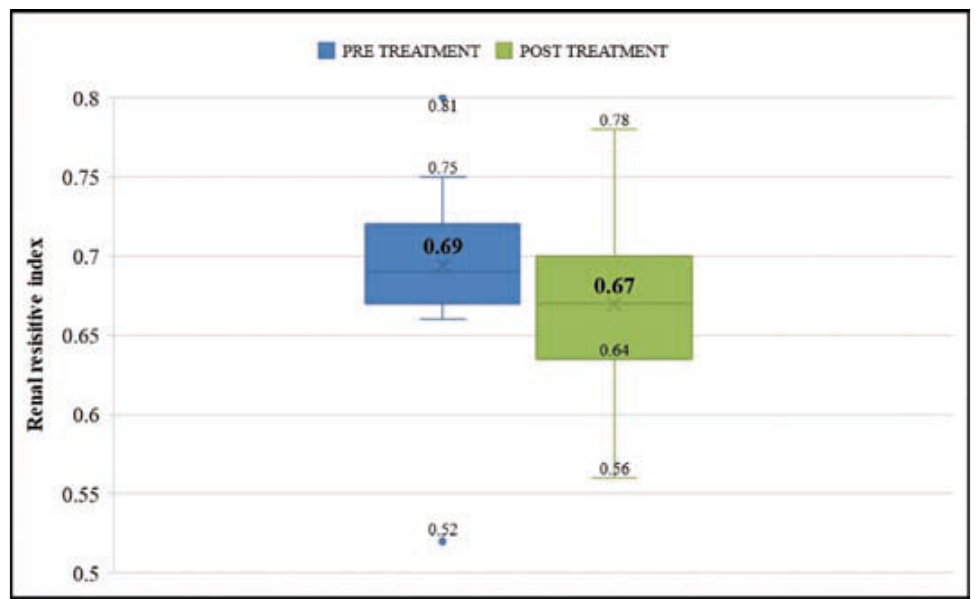
Fig. 6. Whisker-plot representing post-treatment values of RRI table 3. Correlation between RRI and other parameters in dogs with AKI Blood serum creatinine Parameters UPc ratio pressure Kidney size (mg/dl) (mm of hg) Pearson correlation 0.516** -0.164 0.179 -0.031 RRi p-value <0.001 0.41 0.37